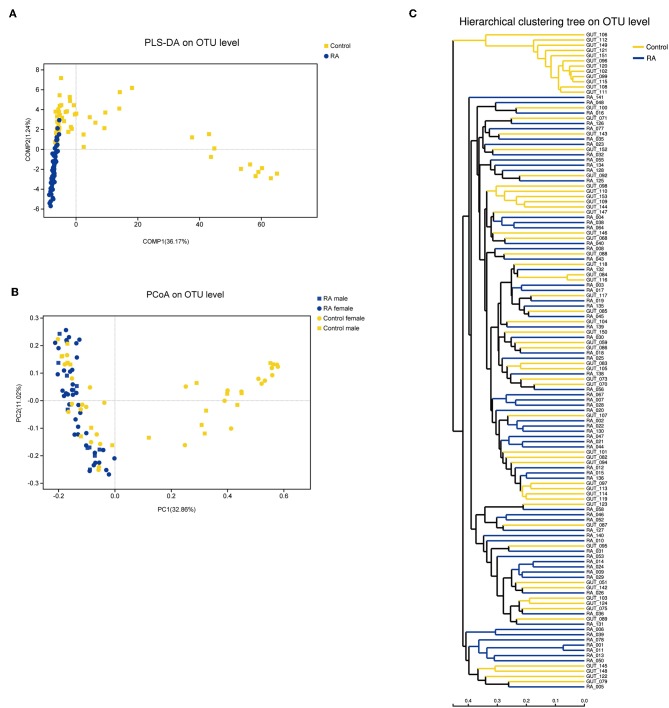
β-diversities of RA group and control group. (A) Partial least squares discriminant analysis (PLS-DA) of the RA and control groups. (B) Principal component analysis (PCoA) plot generated from the weighted UniFrac analysis. The x- and y-axes indicate the first and second coordinates, respectively, and the values in parentheses show the percentages of the community variation explained. The blue and yellow symbols depict microbial enrichment in the RA group and control group, respectively. (C) Hierarchical cluster analysis results obtained using UniFrac software.